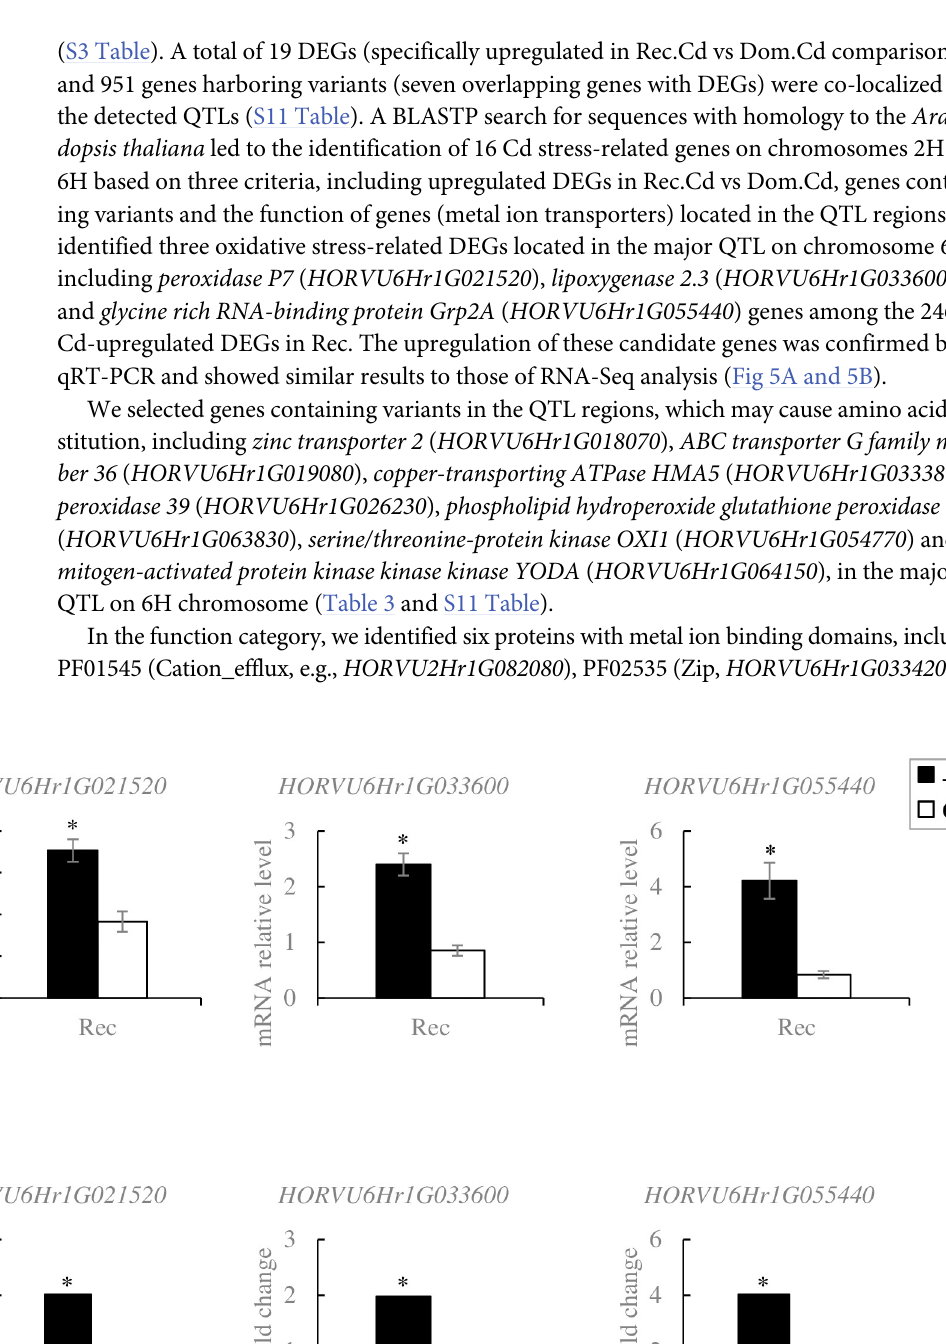
Fig 5. Validation of expression profile for three candidate genes by qRT-PCR. The expression profile of the three candidate genes detected by (A) qRT-PCR and (B) RNA-Seq techniques, which were co-located with the major QTL on 6H chromosome. The relative expression levels of the selected genes were compared with Dom genotype and normalized using an internal control ( Actin ) and calculated based on the 2 − ΔΔ Ct method. For the qRT-PCR data, the mean ± standard error of three technical replicates are represented. Asterisks indicate levels of significance of differential expression tested by the Student’s t-test ( � p � 0.05, �� p � 0.01). Nd: No data.